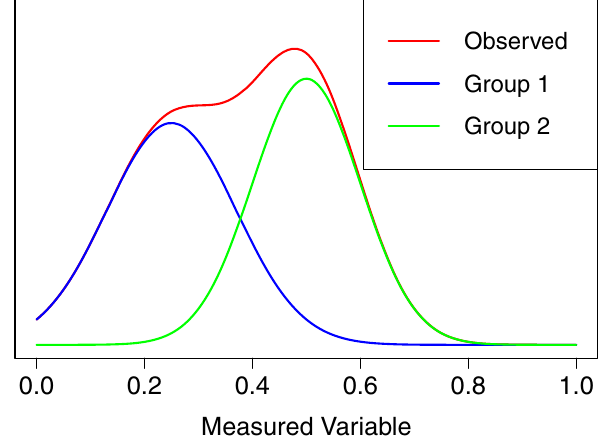
FIG. 1. Given an observed distribution (red), LPA assumes that this observed distribution can be described by a combination of distinct profiles that follow a Gaussian distribution (two groups, shown in blue and green).